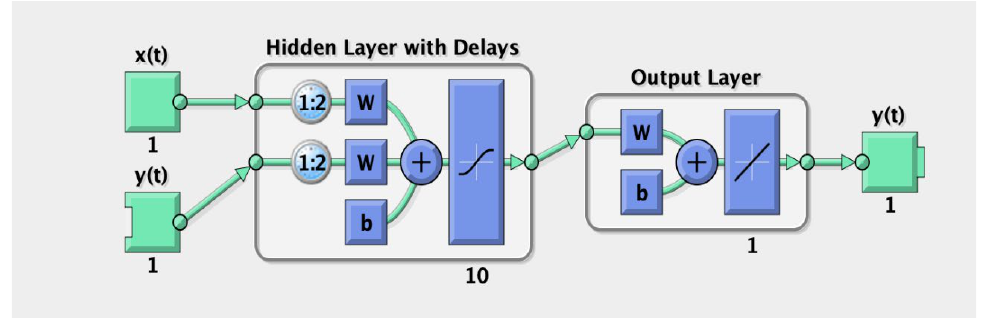
Figure 4. ANN Structure of a wireless sensor system.